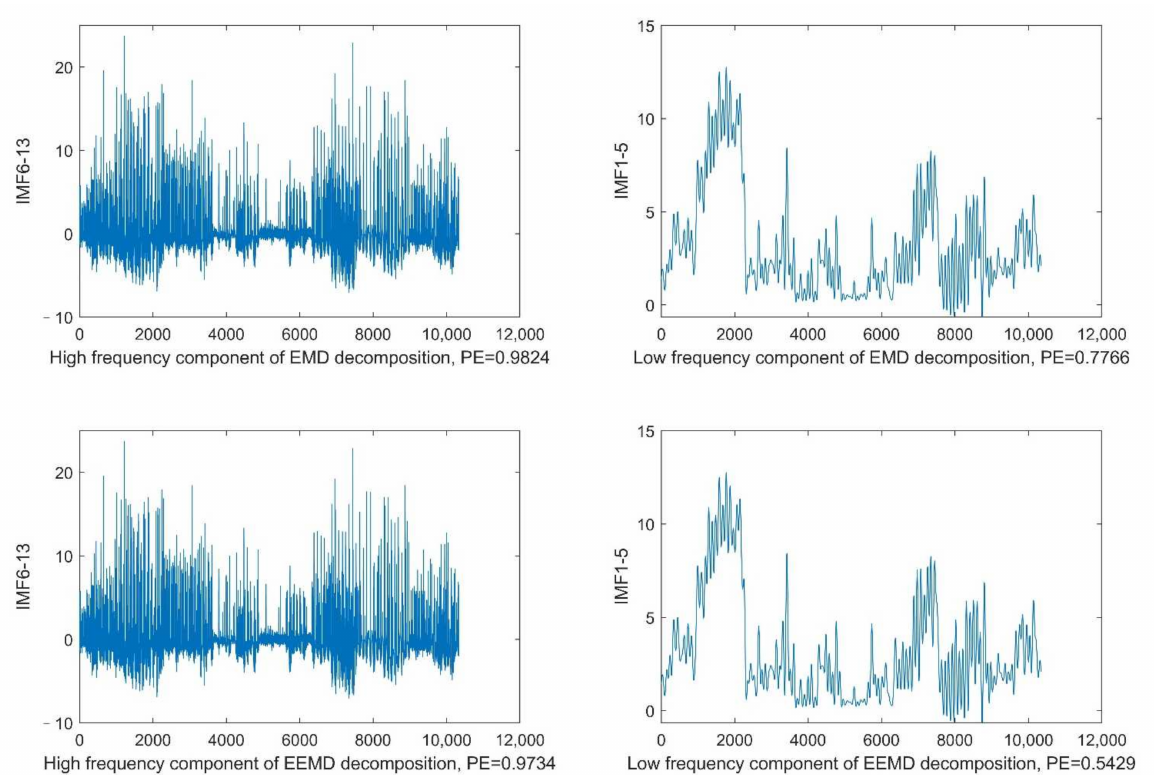
Figure 5. Components of the EMD/EEMD